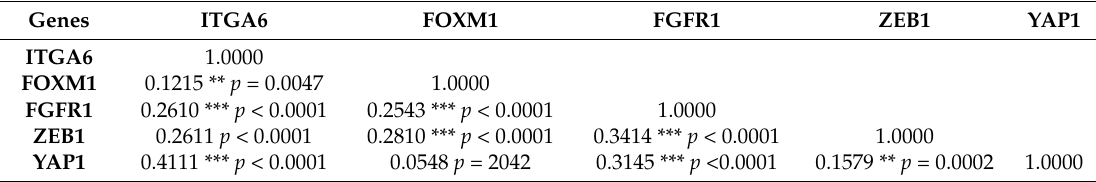
Table 1. Inter-genes correlations in the TGCA database ( n = 539). Values correspond to Spearman’s rank